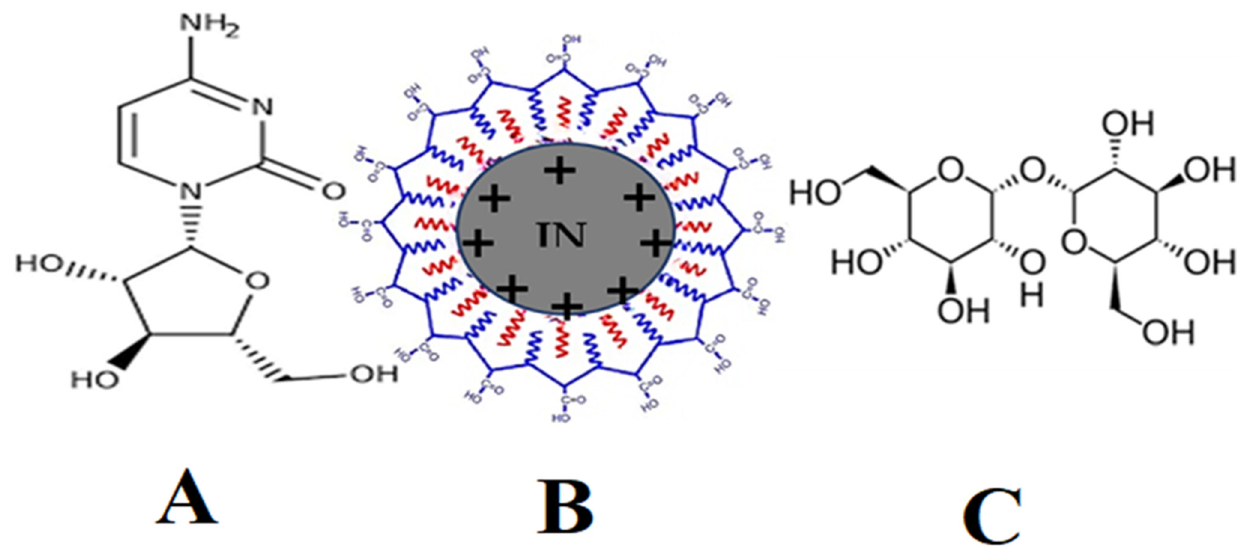
Figure 1. Shows the chemical structure of cytarabine ( A ), iron oxide nanoparticles ( B ), and treha ‐ lose ( C